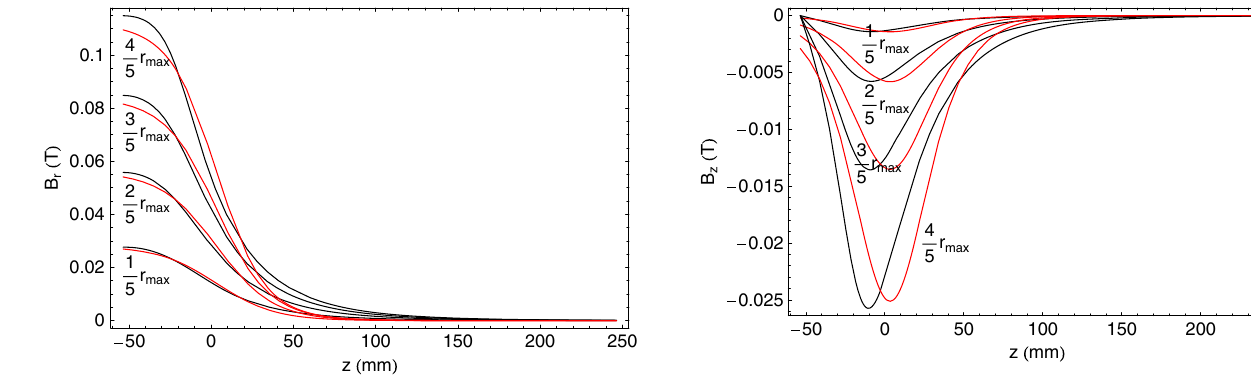
FIG. 13. Longitudinal component of the magnetic field in an FIG. 11. Radial component of the magnetic field in an EMMA EMMA F quadrupole as a function of position along lines of F quadrupole as a function of position along lines of given radius given radius and with cylindrical polar coordinate θ ¼ π = 4 . Each and with cylindrical polar coordinate θ ¼ π = 4 . Each pair of black pair of black and red lines shows the field at an increasing radius, = 5 to and red lines shows the field at a different radius, from r 36 mm. The black lines max = 5 to 4 r = 5 , with r from r 4 r 36 mm. The black lines show the field max max max ¼ = 5 , with r max max ¼ show the field obtained from the (numerical) magnetic model; obtained from the (numerical) magnetic model; the red lines show the red lines show a symmetrized form of the analytical model a symmetrized form of the analytical model (49) – (51), with fit (49) – (51), with fit parameters given in Table II with radius of fit = 10 , and parameters given in Table II with radius of fit r max r = 10 , and b 2 ¼ 1 . 8 . The center of the quadrupole is at the far max b 2 ¼ 1 . 8 . The center of the quadrupole is at the far left of the plot, left of the plot, z ¼ − 53 . 6 z ¼ − 53 . 6 mm.